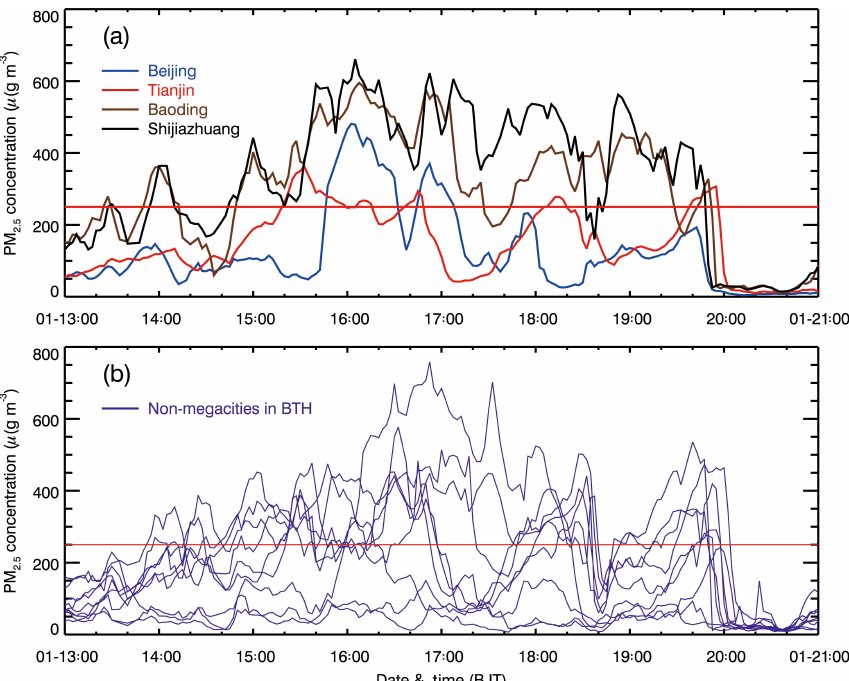
Figure 3. Observed hourly PM 2 . 5 concentrations averaged in (a) four mega-cities (Beijing, Tianjin, Baoding, and Shijiazhuang) and (b) nine non-mega-cities of BTH during the period from 13 to 20 January